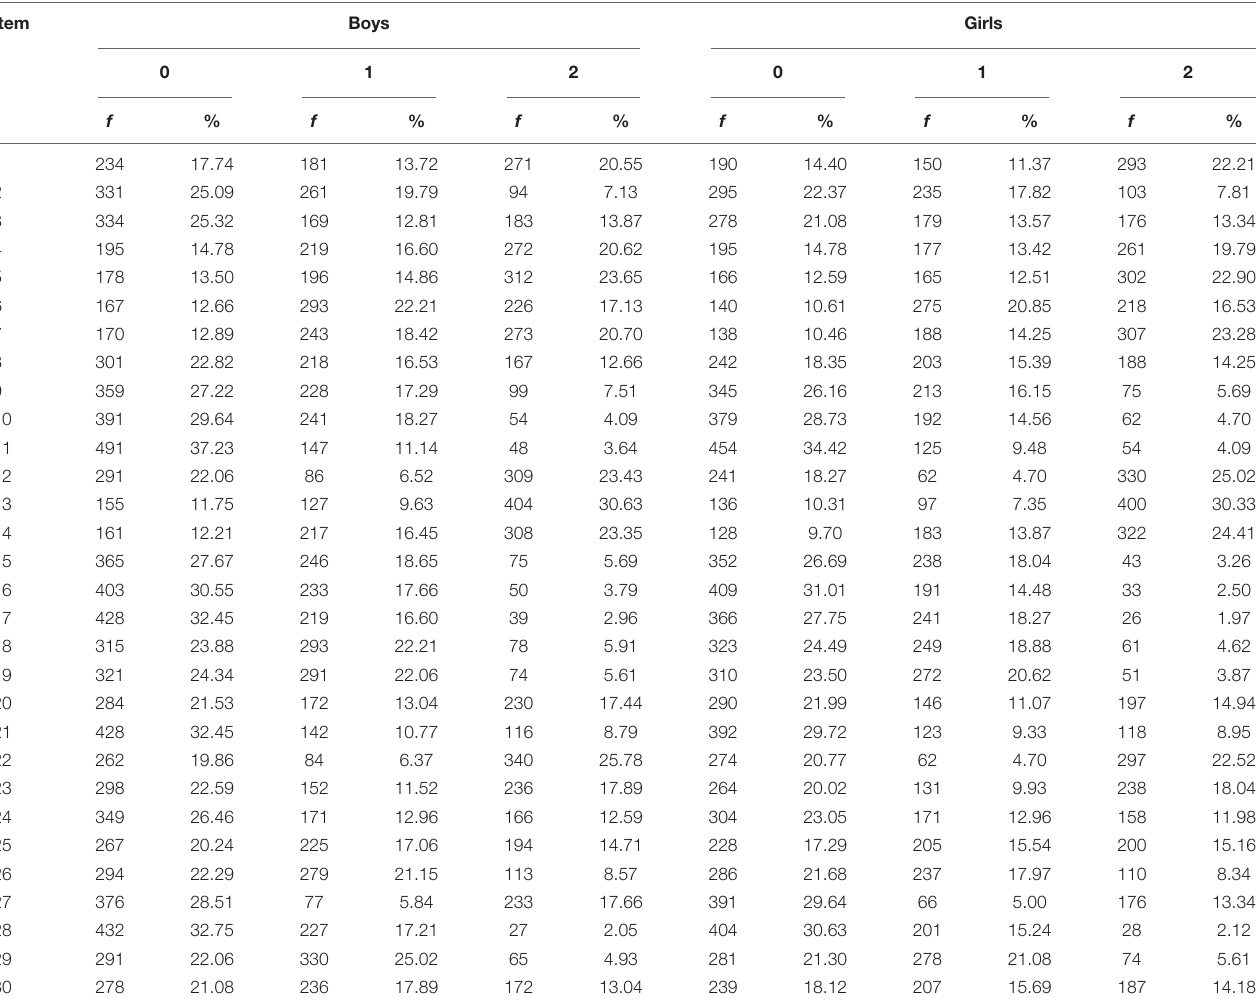
TABLE 7 | Frequencies and percentages by sex from students with level 1